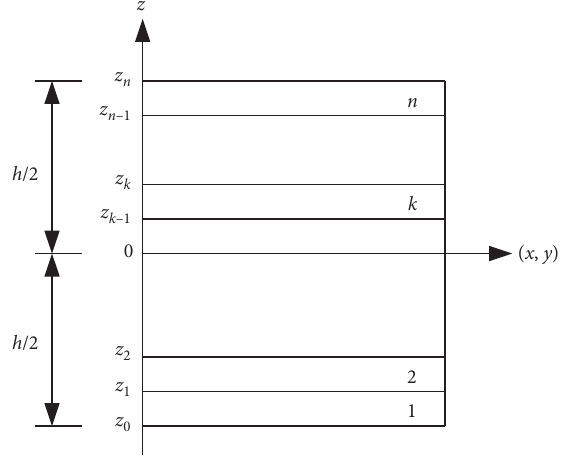
Figure 1: Structure of the n -layer laminated plate. Table 1: Material performance